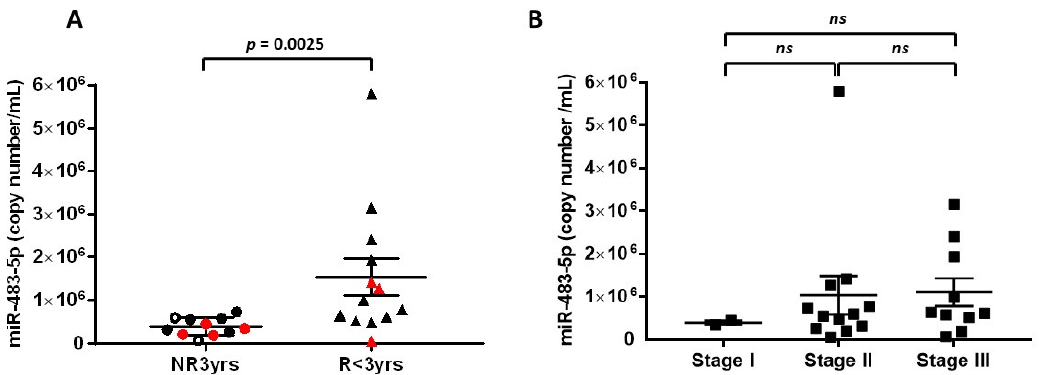
Figure 2. Post-operative serum levels of miR-483-5p in ACC patients. ( A ) Comparison of miR-483-5p levels in NR3yrs ( n = 11) and R < 3yrs groups ( n = 13). Cycle threshold (Ct) values were converted to absolute number of copies/mL using a dilution series of a known input quantity of synthetic target miRNA run simultaneously with the experimental samples. Statistically significant difference was assessed using Mann–Whitney test ( p = 0.0025). Black circles and triangles: patients who received mitotane adjuvant therapy after serum sampling. White circles in the NR3yrs group: Patients 5 and 8 received mitotane adjuvant therapy 0.9 and 1.8 months before serum sampling, respectively. Red symbols: patients with no mitotane therapy throughout their follow-up. ( B ) Comparison of miR-483-5p levels in NR3yrs and R < 3yrs patients in function of ENSAT stage (stage I: n = 2; stage II: n = 12; stage III: n = 10); ns: non-significant. The lines within the scatter plot represent the mean ± S.E.M of miRNA copy number/mL.